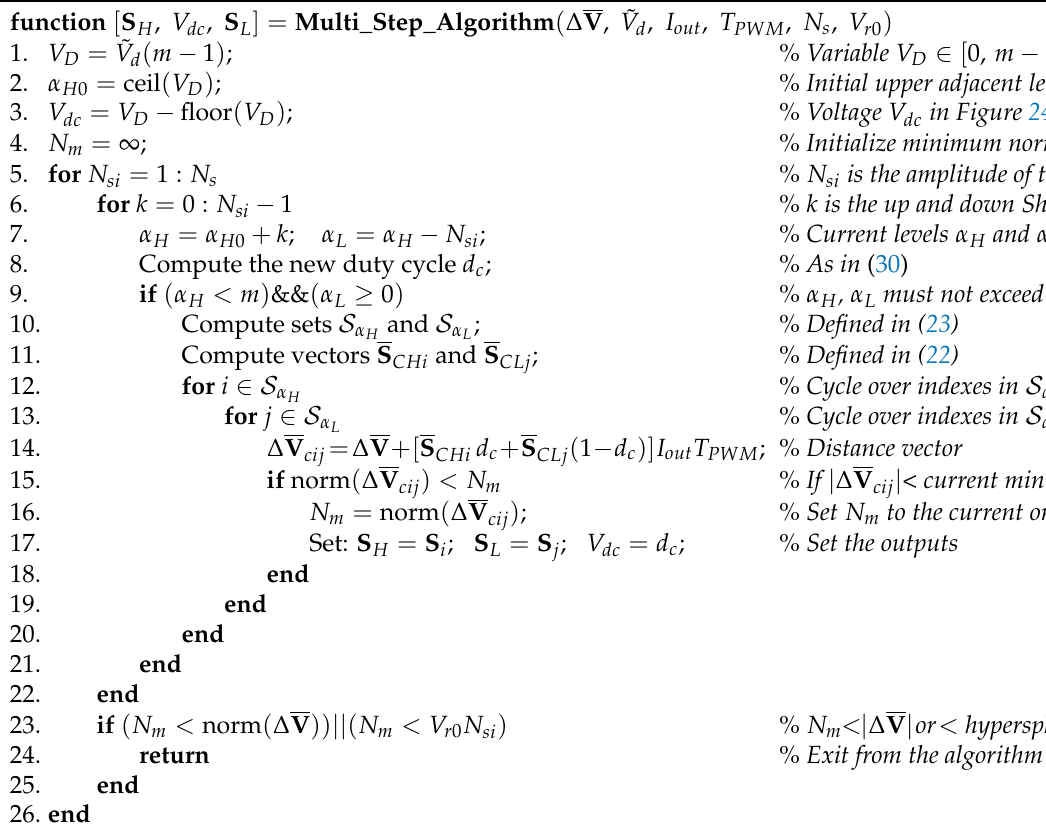
Figure 26. Matlab-like form of the Variable-Step Control